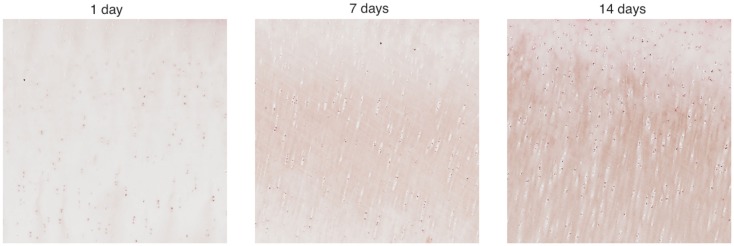
Zoomed areas from Figure 2. These samples have been stained to measure EPO concentrations, which are shown to increase as time progresses.